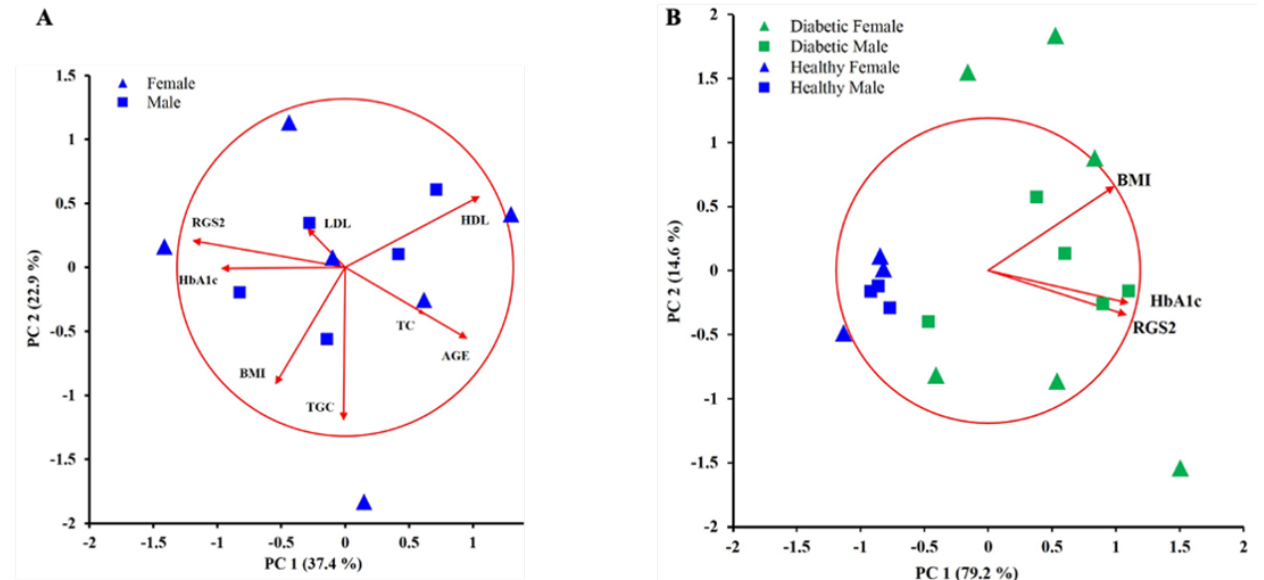
Figure 3. Correlation biplots are showing the variability explained by the new sets of variables conforming PC1 and PC2. ( A ) Exploratory principal component analysis (PCA) of nine different variables for eleven T2DM patients; scatter plot showing the position for each one of the T2DM patients within PC1 and PC2 dimension. PC1 was negatively formed by RGS2 and HbA1c, and positively by HDL and age, while TGC and BMI formed PC2. There is no apparent clustering of T2DM subjects, except that seven T2DM subjects were distributed along PC1 (between 0.5 and −0.5 of PC2). Blue triangles correspond to T2DM females; blue squares correspond to T2DM males. ( B ) PCA analysis for the same diabetic subjects shown in ( A ) and RGS2, HbA1c, and BMI for six healthy donors (in blue). In this case, all these three variables correlated heavily with PC1. The latter clustered at the low end of RGS2 and HbA1c, while T2DM subjects clustered at the high end of RGS2 and HbA1c. In this sample, it was found that T2DM females displayed a large variability in BMI compared with diabetic males (see Table 1). Green triangles correspond to T2DM females; blue triangles correspond to healthy females. Green squares correspond to T2DM males; blue squares correspond to healthy males.